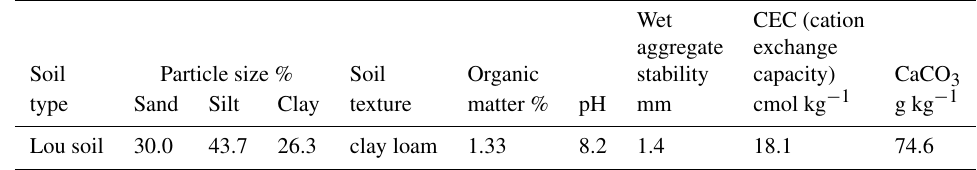
Table 1. Selected chemical and physical properties of the soil.